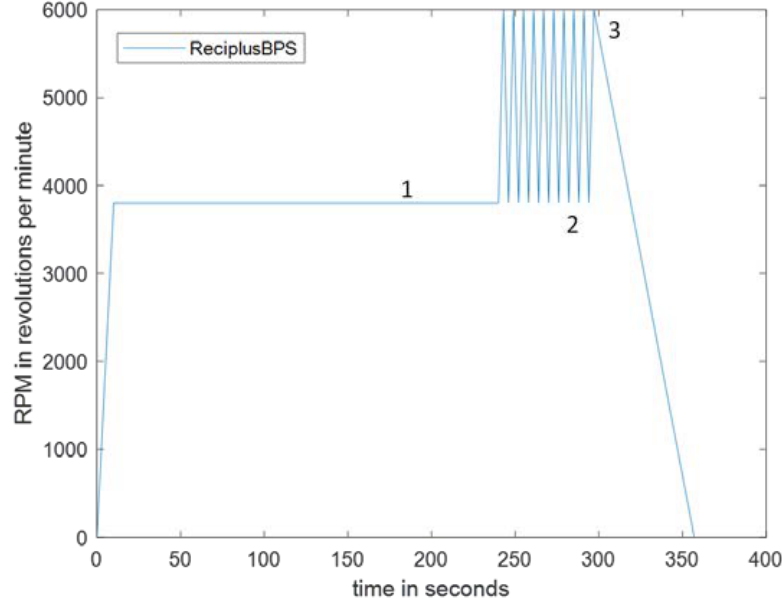
Figure 3. The spin profile of the integrated CD, which consists of (1) the plasma separation and red blood cells sedimentation, (2) the reciprocation regime implemented to pass the sample multiple times over the microarray in the reciprocation chamber, and (3) the slowing down of the spinning CD at 60 RPM/s. Table 1. Comparison of Integrated blood plasma separation with Standard Reciprocation system that uses two CDs [1,2].